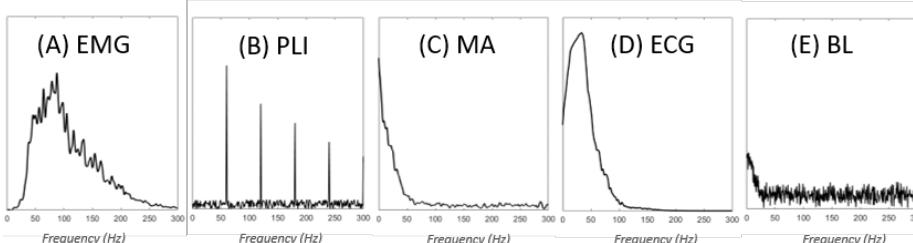
Figure 1. Power spectrum of the EMG signal ( A ) and of some of its contaminants: power line interference ( B ), motion artifact ( C ), electrocardiographic signal ( D ) and baseline noise ( E